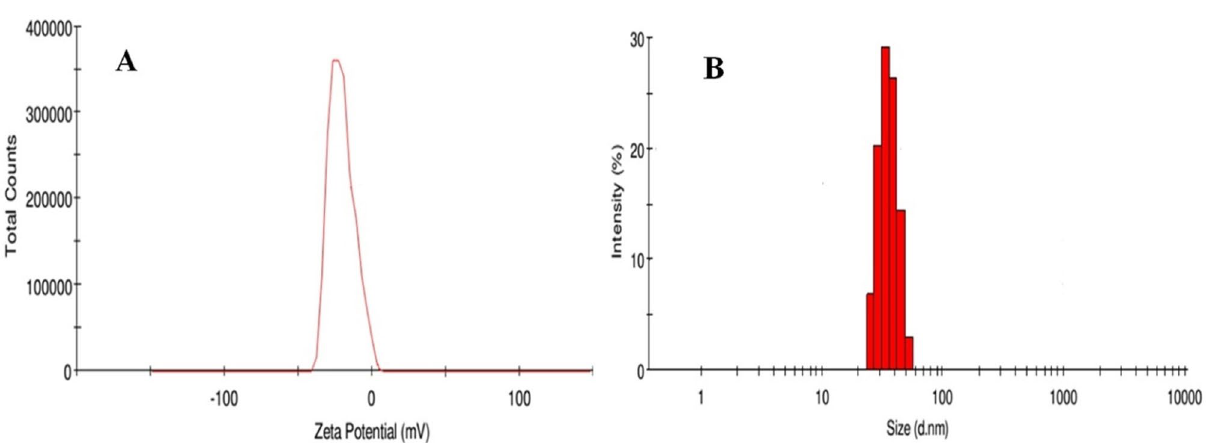
Figure 5. Rapid synthesized SeNPs ( A ) Zeta potential analysis ( B ) DLS